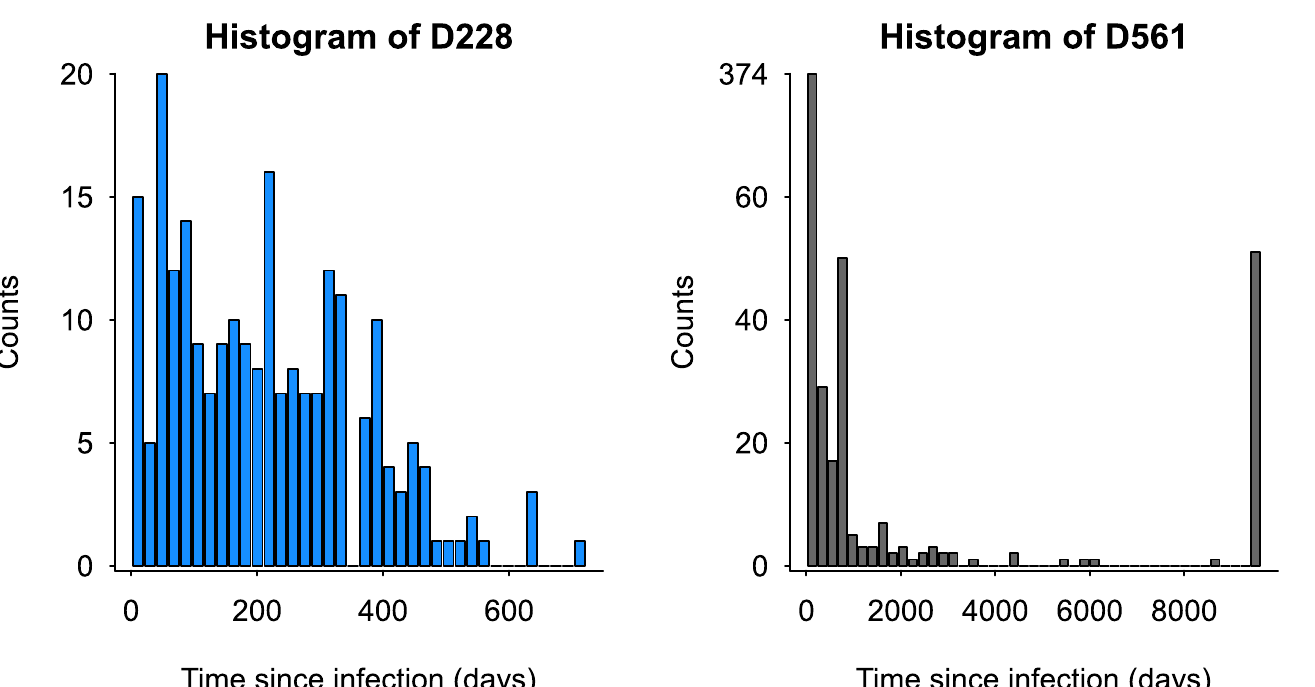
Fig 1. Empirical time since infection distributions of two available datasets. On the left, D228 represents 228 samples (from 42 subjects) with recent infection of subtype C in Botswana from 2004 to 2008. Subjects were followed longitudinally for no more than 755 days [17]. On the right, D561 represents a meta database (freely available at Los Alamos HIV public database; accessed August 2014) of 561 samples (from 462 subjects) with subtype B and C. The maximum TSI is 8888 days.